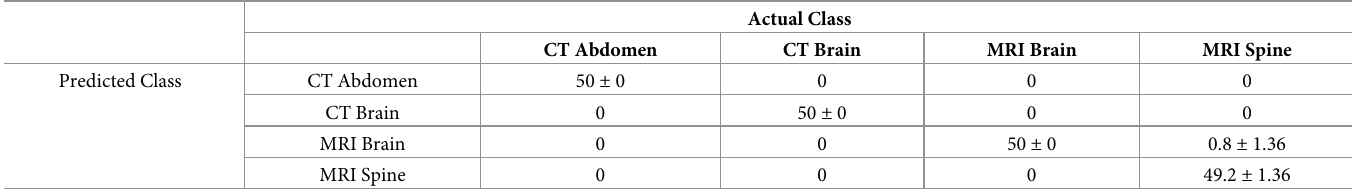
Table 4. Multi-class confusion table for testing set of the five attempts.